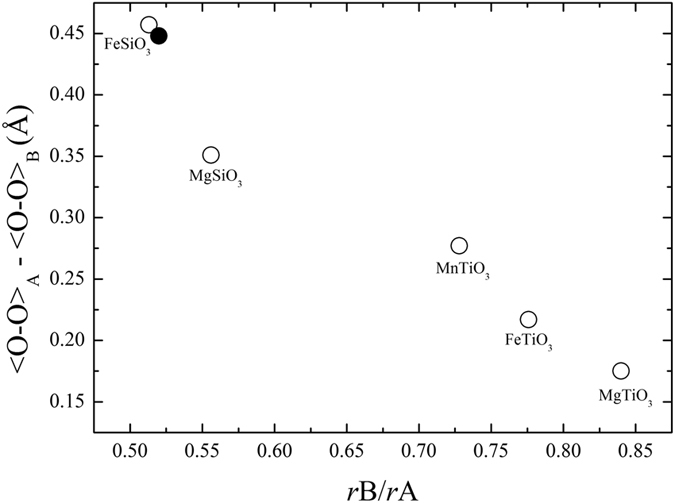
Structural details of hemleyite.The difference between the O-O edge of the A and B sites (in Angstrom), which is directed along the c-axis, plotted as a function of the ratio between the ionic radius of the B and A cation. Filled circle corresponds to hemleyite (this study), whereas empty circles refer to literature data as follows: FeSiO341, MgSiO338, MnTiO359, FeTiO360, MgTiO361.